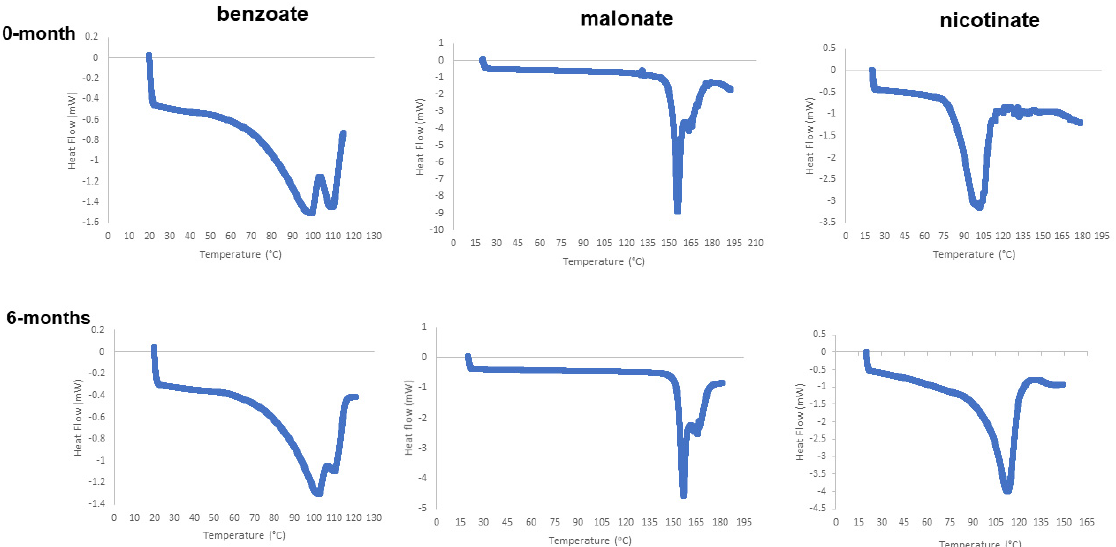
Figure 14. DSC results for 6-month stability samples of new bedaquiline salts closely matched the endotherms observed at the start point (0 months).